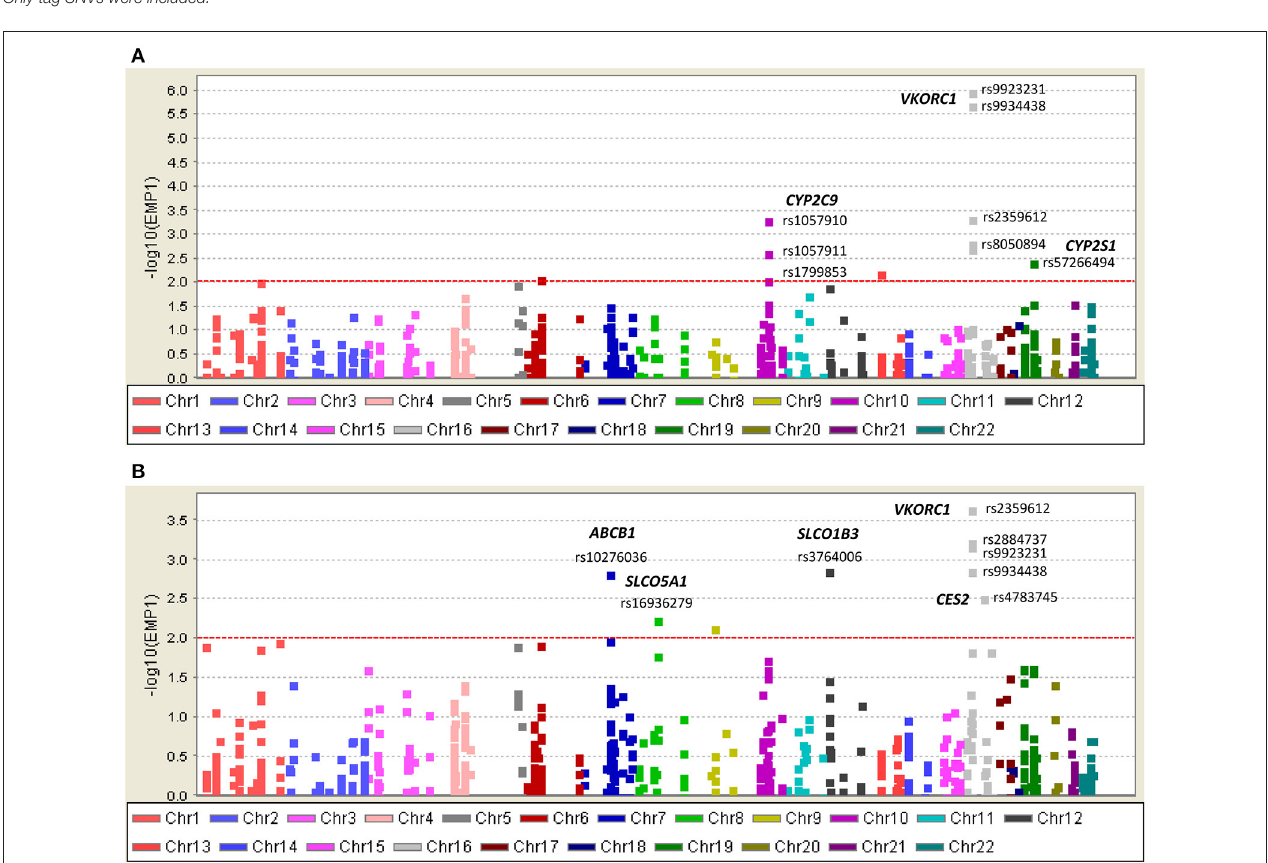
FIGURE 4 | Single nucleotide variants (SNVs) associated with warfarin (A) sensitivity ( < 4 mg/day) and (B) resistance ( > 6 mg/day) identified with DMET Plus array.